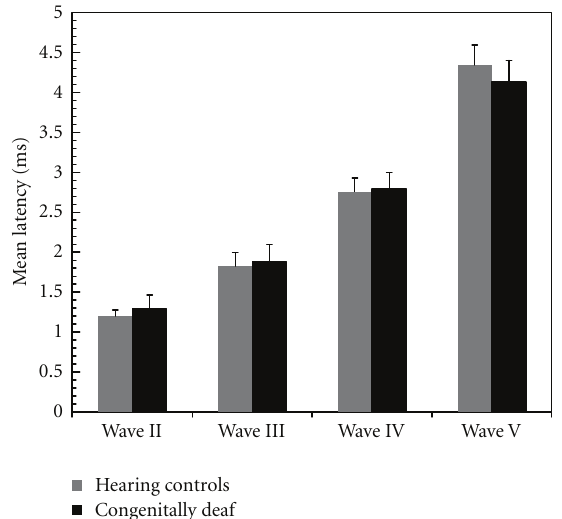
Figure 7: Mean peak latencies of all waves in matured animals (older than 3 months). No statistically significant di ff erences were observed between CDCs and hearing